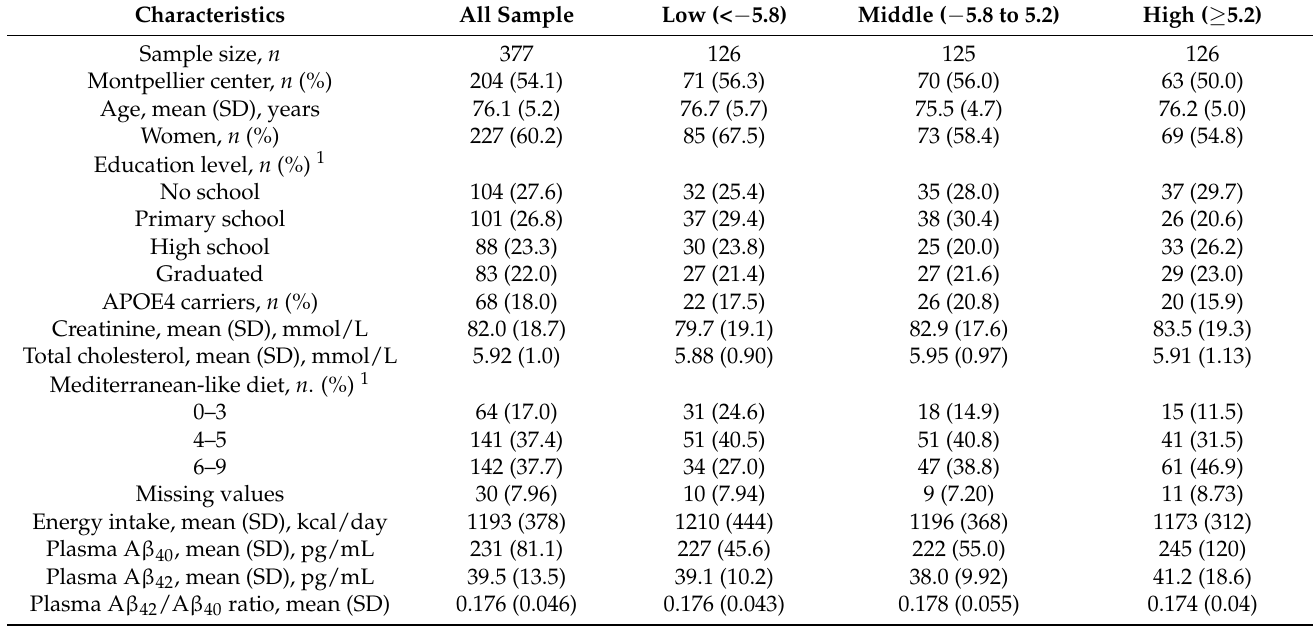
Table 1. Characteristics of the study sample according to the tertile of the total GL